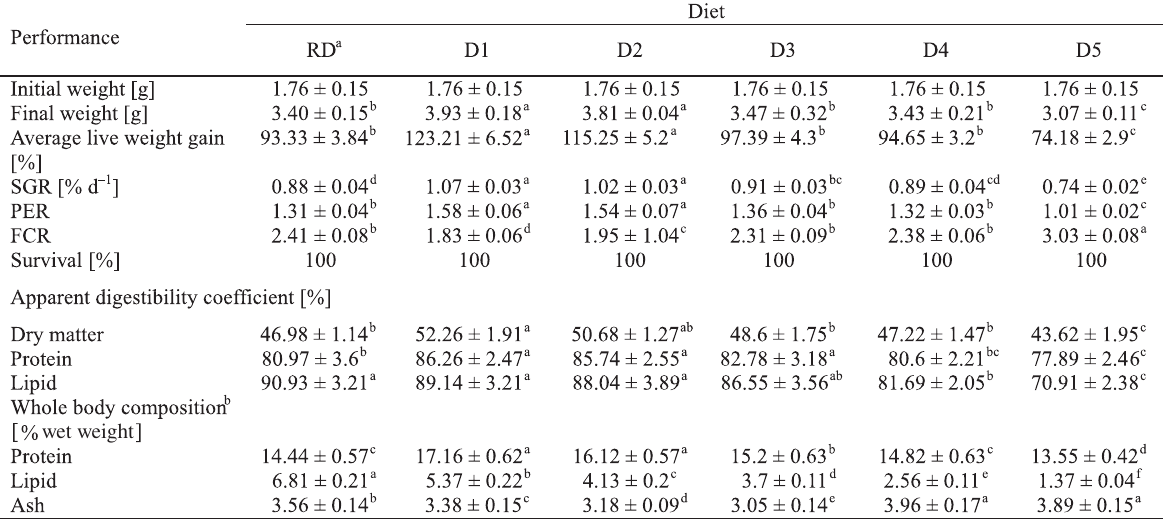
Growth performance, apparent nutrient digestibility, and carcass composition of fish fed experimental diets for 75 days (mean ± standard deviation of 3 determinations)